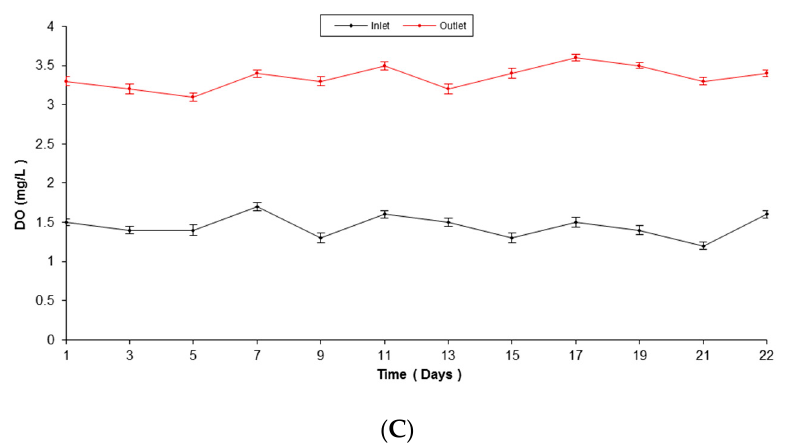
Figure 5. ( A ) MLSS profile in continuous mode aerobic digester (PBBR sludge); ( B ) MLVSS profile in continuous mode aerobic digester (PBBR sludge); ( C ) MLVSS profile in continuous mode aerobic digester (PBBR sludge).